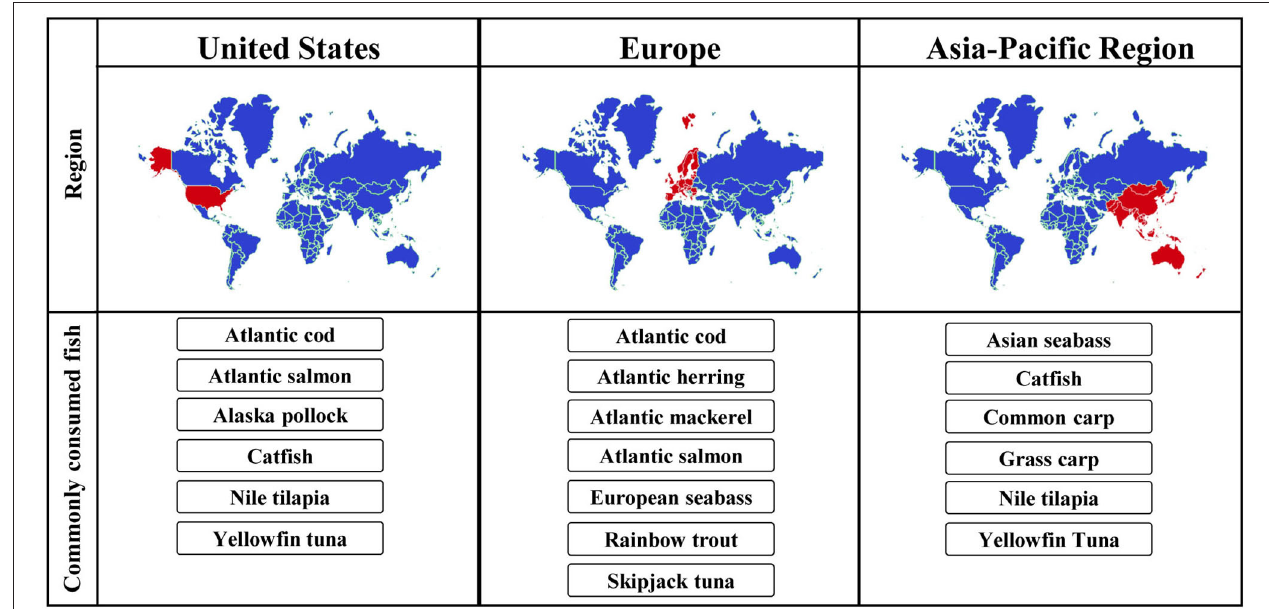
FIGURE 2 | Most commonly consumed fish species in different geographic